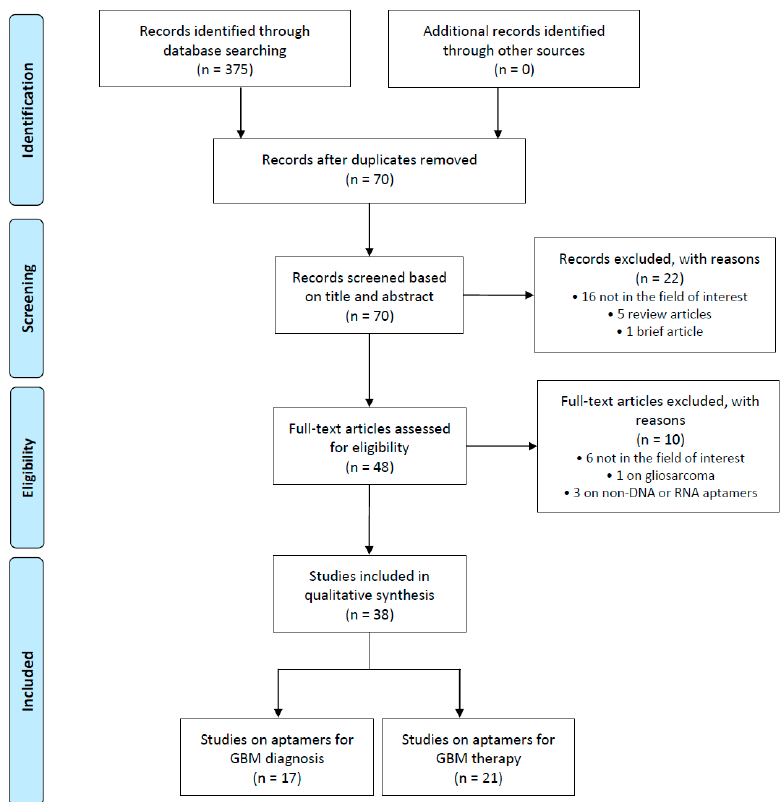
Figure 1. Preferred Reporting Items for Systematic Reviews and Meta ‐ Analyses (PRISMA) flow Figure1. diagram .